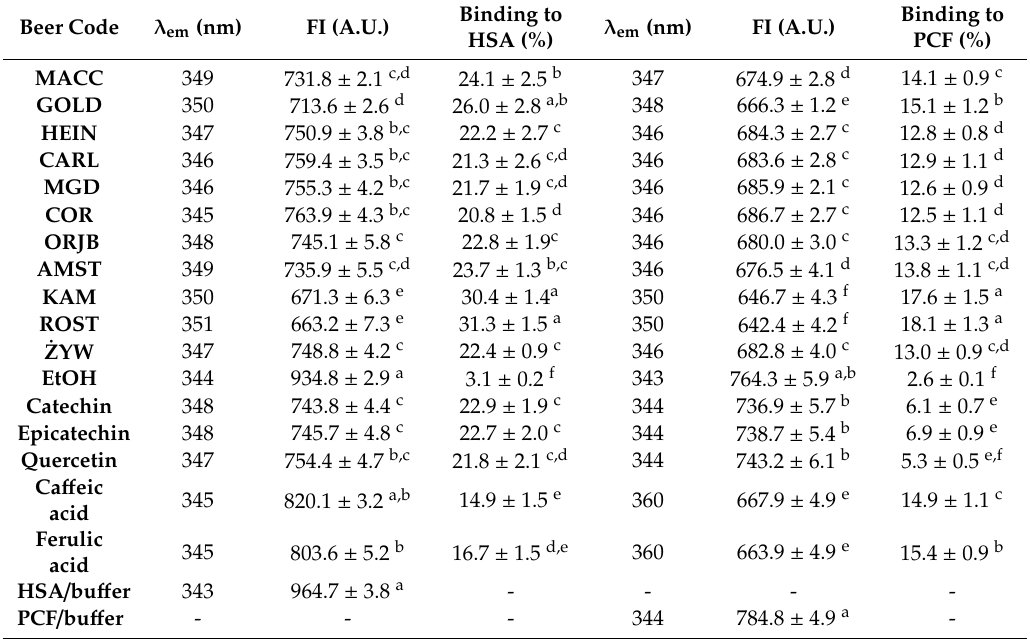
Values are means ± SD of 5 measurements; Means within a column with the di ff erent superscripts are statistically di ff erent ( p < 0.05; Student’s t -test). Abbreviations: Maccabee (MACC); Goldstar (GOLD); Heineken